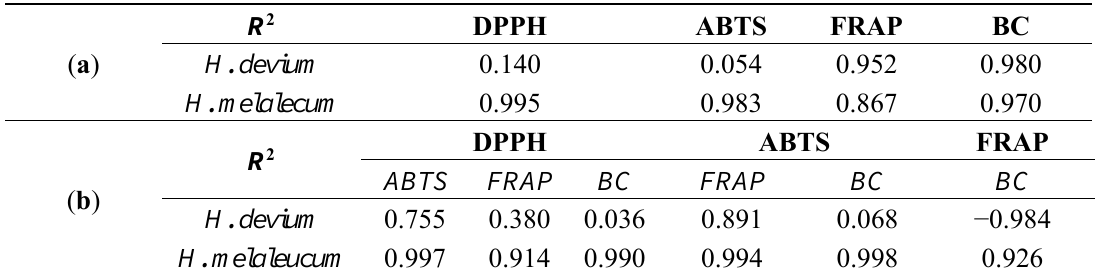
Table 2. ( a ) The Pearson correlation coefficients between the total phenolic content (TPC) and the antioxidant assays data (DPPH, ABTS, FRAP and BC); ( b ) the Pearson’s correlation coefficients between antioxidant assays